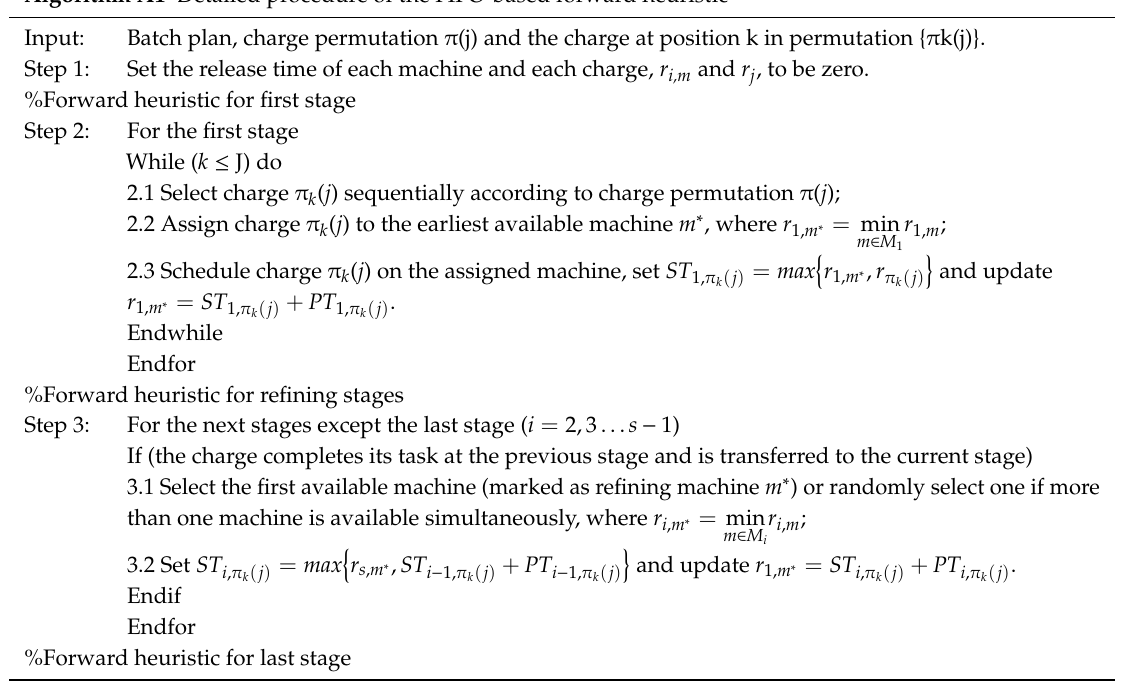
Algorithm A1 Detailed procedure of the FIFO-based forward